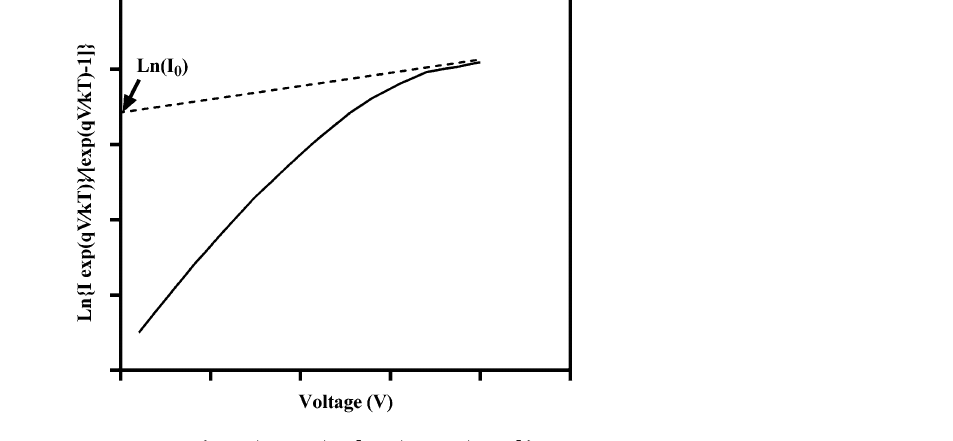
Figure 6. Ln vs.V of a MSM PD.